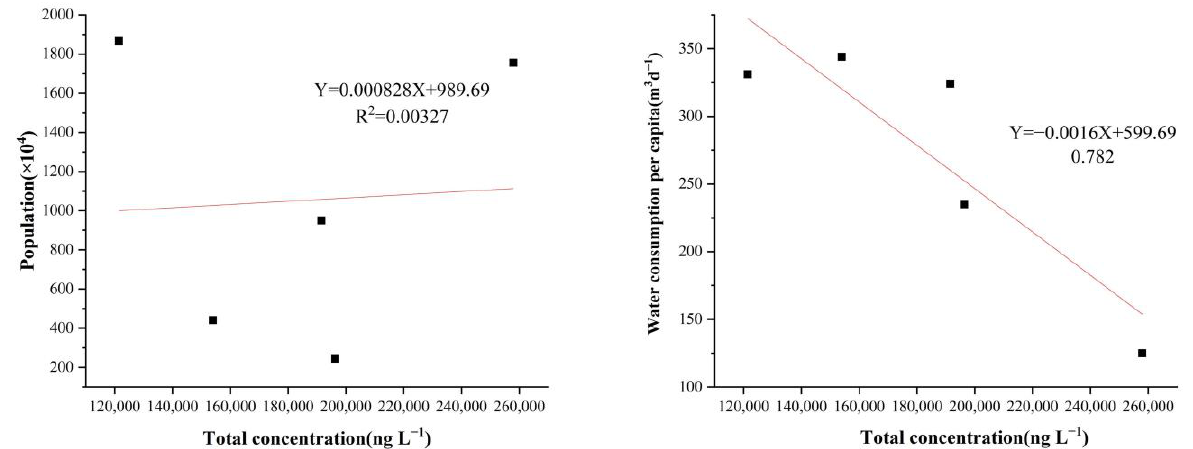
Figure 3. Correlation between the total concentration of 30 target antibiotics and the population served by the pharmaceutical plants, GDP per capita, water consumption per capita, and pharma- ceutical usage amount per day in the regions with pharmaceutical